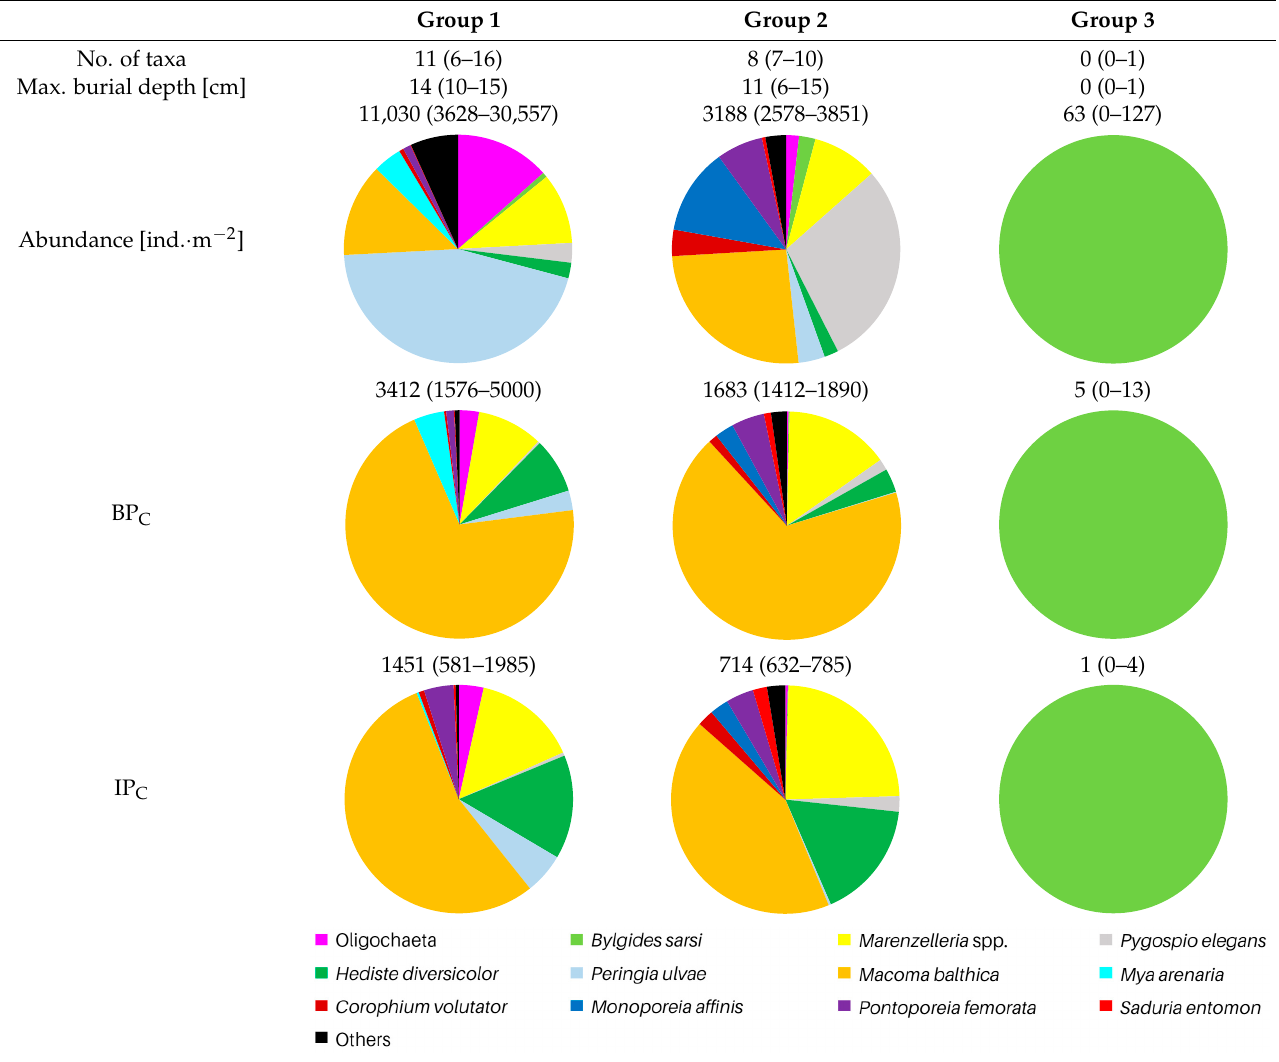
Table 3. Number of taxa, maximum burial depth of macrofauna, mean values: abundance, BP C and IP C (min.–max), contribution of individual taxa to the formation of these parameters, and in each group of sites provided in Figure 3.